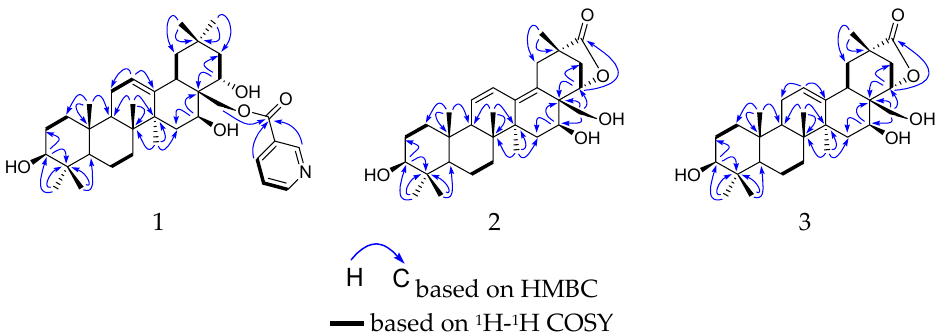
Figure 2. Key 1 H ‐ 1 H COSY and HMBC correlations of compounds 1 – 3. Figure 2. Key 1 H- 1 H COSY and HMBC correlations of compounds 1 – 3 .